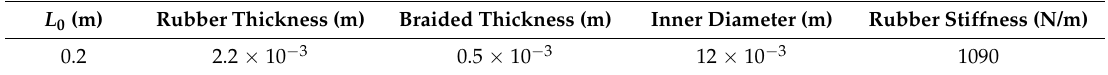
Table 2. The initial specifications of a high stiffness, 20 cm.